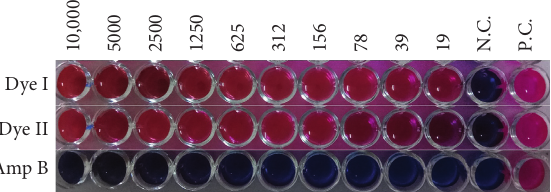
Figure 4: In vitro antileishmanial activity against Leishmania infantum promastigotes; dye I, dye II, control drug amphotericin B, and dilution concentrations 10000-19 μ g/mL. NC: negative control and PC: positive